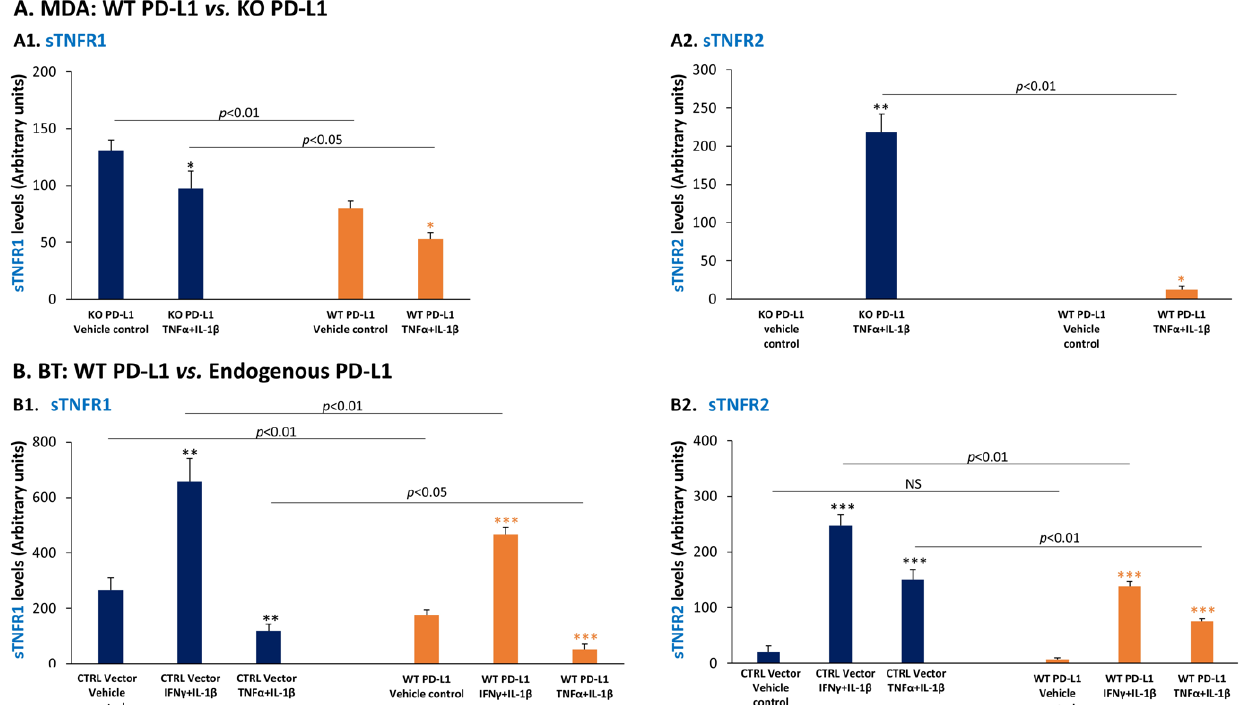
Figure 11. In MDA-MB-231 and BT-549 cells, elevated PD-L1 levels lead to down-regulation of protective sTNFR1 and sTNFR2. ( A ) MDA-MB-231 cells (MDA) and ( B ) BT-549 cells (BT) were treated by pro-inflammatory cytokines or their vehicle control for 48–96 h, and the expression levels of cell-derived sTNFR1 ( A1 , B1 ) and of cell-derived sTNFR2 ( A2 , B2 ) in cell CM were determined by ELISA; sTNFR1 and sTNFR2 levels are presented as arbitrary units, derived from normalization of protein levels to cell numbers, due to higher proliferation rates of WT PD-L1-expressing cells compared to cells that did not express PD-L1 (“KO PD-L1” cells in MDA) or that expressed low endogenous PD-L1 levels (“CTRL Vector” cells in BT). ( A ) MDA cells included cells in which the endogenous expression of PD-L1 was KO by CRISPR-Cas9, and were then infected to express WT PD-L1 (termed “WT PD-L1” cells) or a vector control (“KO PD-L1” cells). Cells of both types were stimulated by TNF α + IL-1 β (concentrations as in Figure 1) or treated by vehicle for 48 h. ( A1 ) sTNFR1 levels. ( A2 ) sTNFR2 levels. The expression levels of PD-L1 by MDA cells have been demonstrated